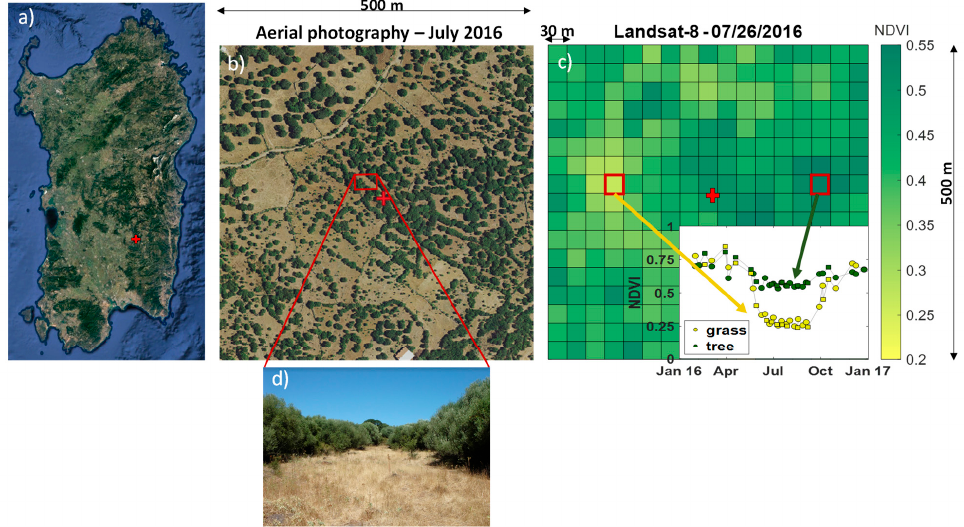
Figure 1. Representation of the Sardinian heterogeneous ecosystem: ( a ) the position of the tower (red cross) in Sardinia; ( b ) aerial photography of summer 2016 with the position of the eddy covariance tower (red cross); ( c ) the NDVI map from a Landsat 8 image with the position of the eddy covariance tower (red cross), and the representative grass and tree cells, which NDVI evolutions in time during the 2016 year are reported in the inset; ( d ) a picture of the landscape on a dry summer day.